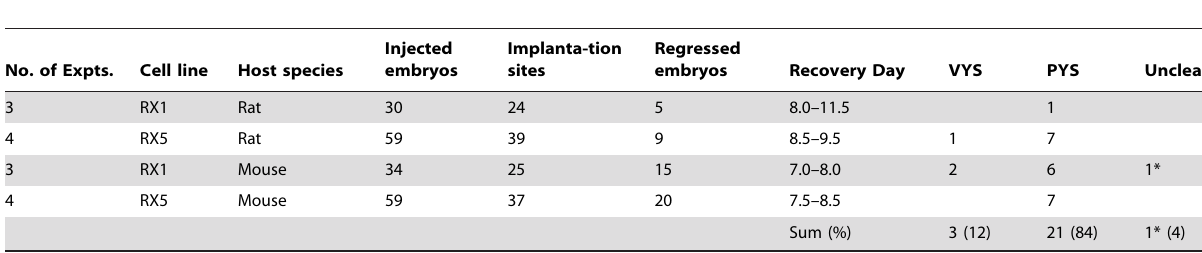
Table 2. Incorporation of cells rat XEN-P cell lines into postimplantation conceptuses.